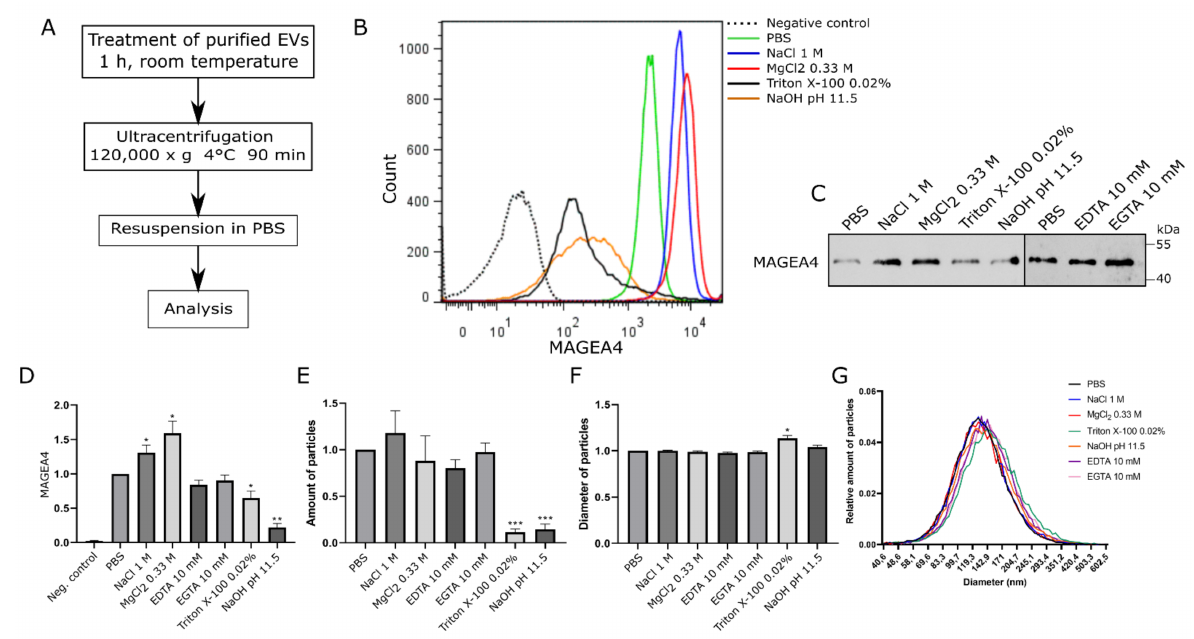
Figure 3. MAGEA4-EVs are resistant to high salt concentrations but vulnerable to high pH. ( A ) The scheme of the experiment. MAGEA4-EVs were treated with different chemicals for 1 h at room temperature. After the treatment, vesicles were purified by ultracentrifugation through PBS at 120,000 × g for 90 min. ( B ) Analysis of MAGEA4 on the surface of EVs using flow cytometry with anti-MAGEA4 and Alexa 488-conjugated secondary antibodies. The dotted line is a negative control (latex beads without EVs), and PBS marks the positive control (MAGEA4-EVs without any treatment). ( C ) Western blot analysis of MAGEA4-EVs after treatment with chemicals using antibodies against the MAGEA4 protein. ( D ) The mean fluorescence intensity (MFI) values of the corresponding flow cytometry histograms in ( B ). ( E ) The amount and ( F ) average diameter of vesicles as measured by NTA. Data shown are average of three independent experiments. In all cases, the relative values, where the control was set as 1, are shown. ( G ) The relative amount of EVs by diameter as measured by NTA. The results indicated with * had a statistically significant difference compared to value of PBS-treated sample: * p -value < 0.05; ** p -value < 0.01; *** p -value <